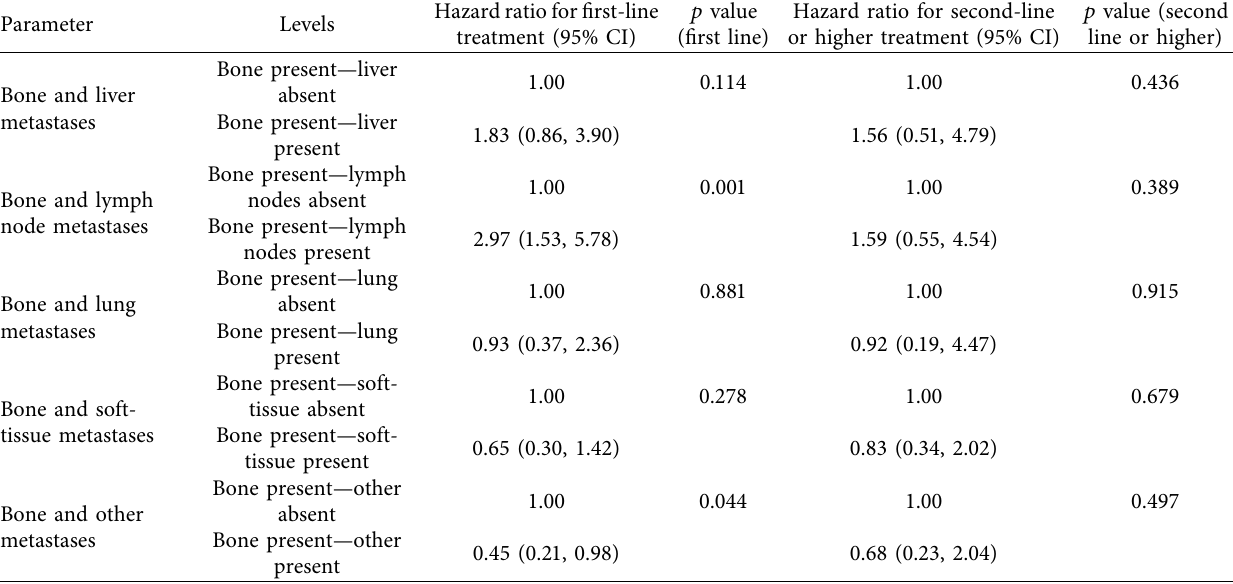
Table 5: Cox model for the effect of bone metastasis combined with another metastatic organ site on OS stratified by study. Parameter Levels